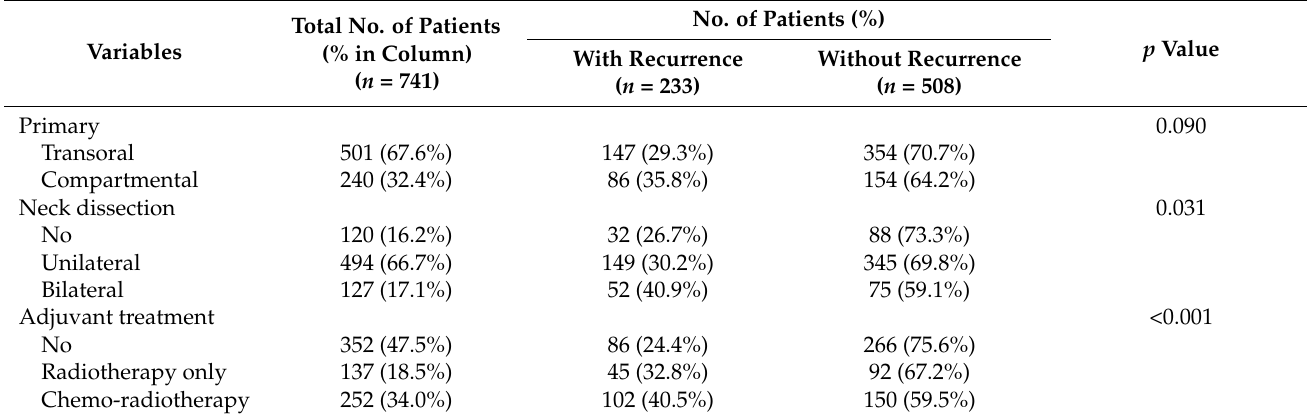
Table 2. Descriptive statistics of treatment modalities of oral cavity cancer patients based on recurrent status.